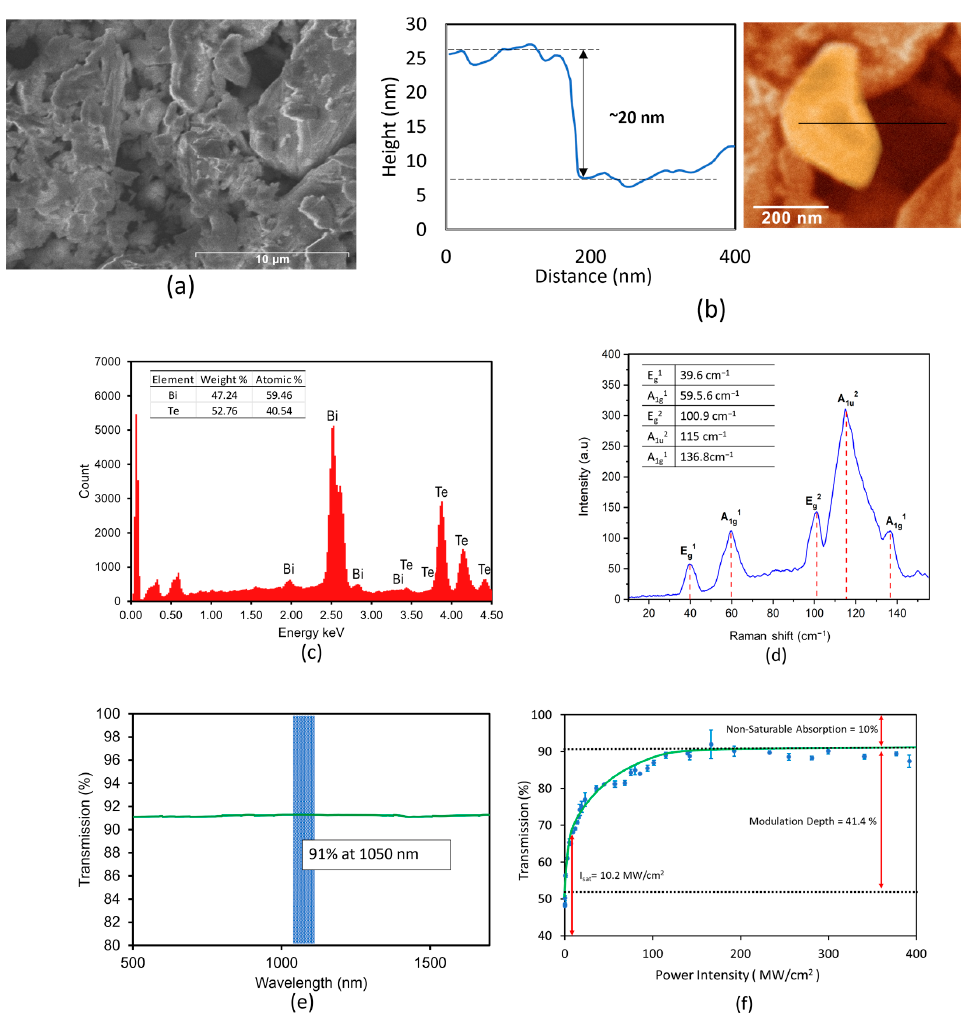
Figure 2. Characterization of Bi 2 Te 3 : ( a ) FESEM image; ( b ) AFM topography of Bi 2 Te 3 ; ( c ) EDX analysis; ( d ) Raman spectrum; ( e ) linear transmission spectrum; and ( f ) nonlinear transmission curve.